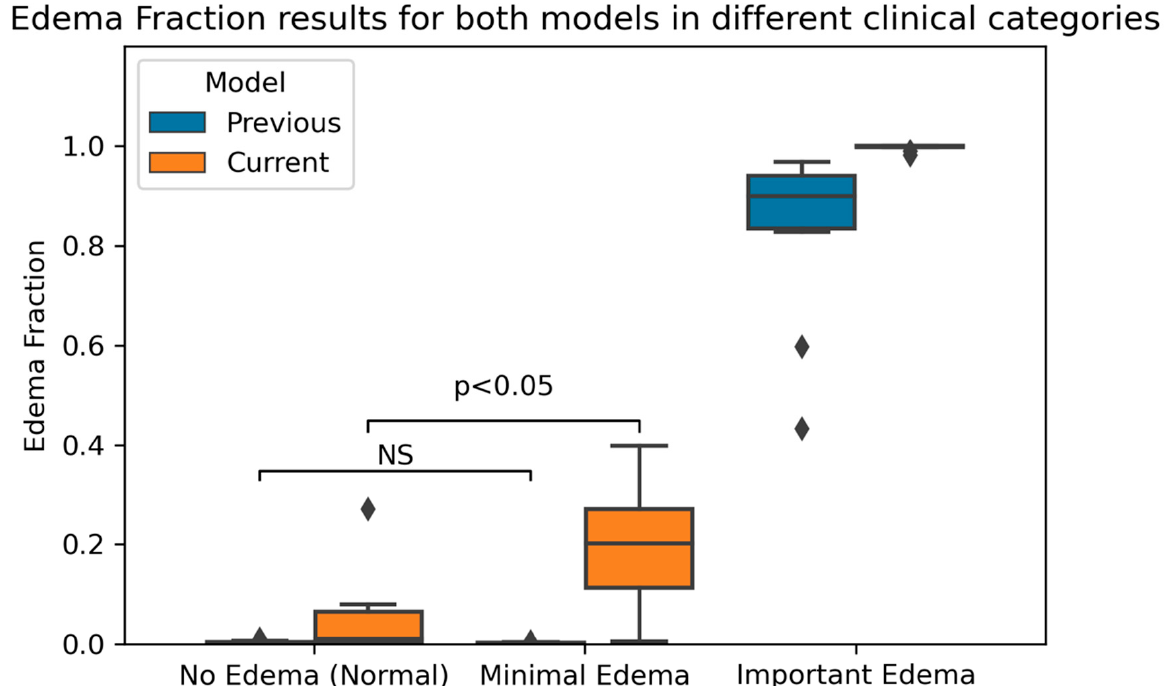
Figure 5. Boxplot of edema fraction for each group and each model. NS: not significant.